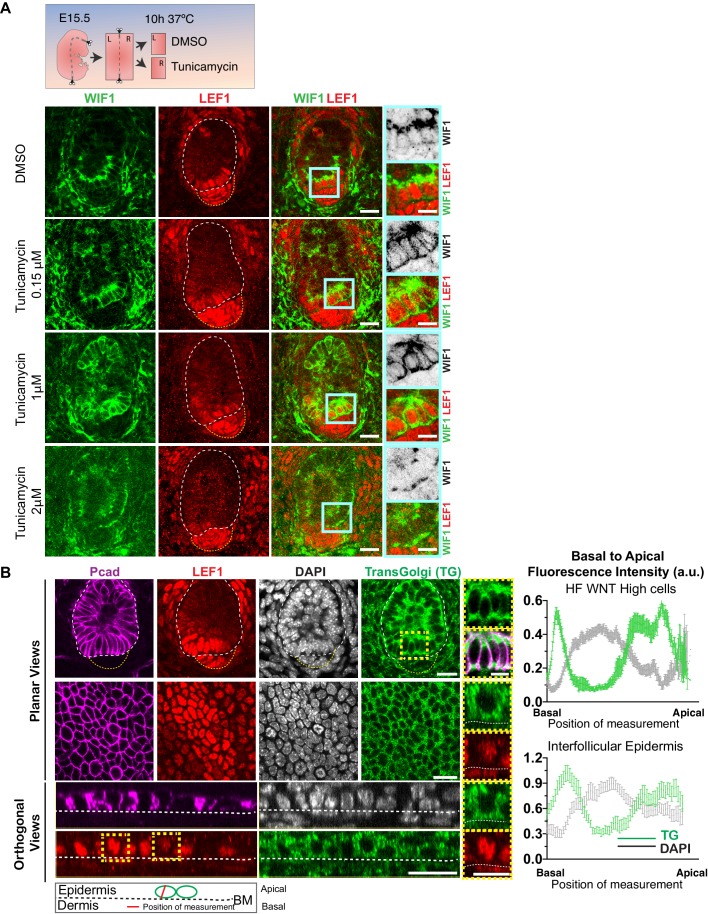
Apical WIF1 localization is dependent on N-Glycosylation.(A) Strategy to test the importance of N-Glycosylation for WIF1 apical localization. E15.5 wild-type embryonic skin explants were treated with different Tunicamycin concentrations for 10 hr and fixed afterwards for whole-mount immunofluorescence analysis. Note increasingly mis-polarized endogenous WIF1, shifting from apical to basal, as the concentration of Tunicamycin is raised. Insets show higher magnifications of boxed regions. (B) Localization of the endogenous Trans-Golgi network in the developing hair follicles and interfollicular epidermis (IFE) and their respective basal-apical pixel intensity profile measured in 21 WNT-signaling progenitor cells and 31 IFE cells (mean ± SEM. a.u., arbitrary units). Insets show higher magnification of selected regions. Note that Golgi is present both basally and apically within the bud progenitors. Scale bars, 20 μm. Inset scale bars, 10 μm.Figure 4—figure supplement 1—source data 1.Source data for the graphs shown in Figure 4—figure supplement 1B.